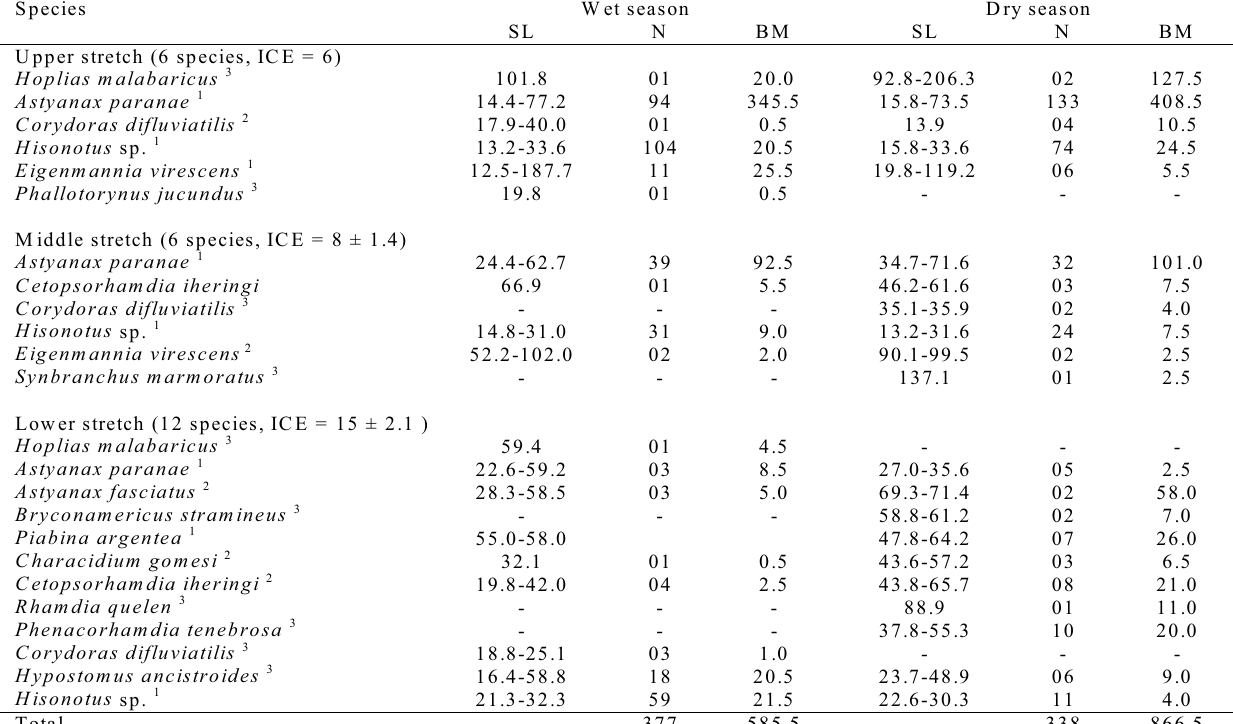
Fig. 5. Similarity dendrogram between 13 fish species from Paulicéia stream based on percent composition of Table 2. Fish species collected in each studied stretch of the Paulicéia stream, during the wet and dry season. SL = range of standard length (mm), N = number of specimens, BM = biomass and ICE = Incidence-based coverage estimator (± standard error). ( 1 ) resident species; ( 2 ) accessory species; ( 3 ) accidental species. Species